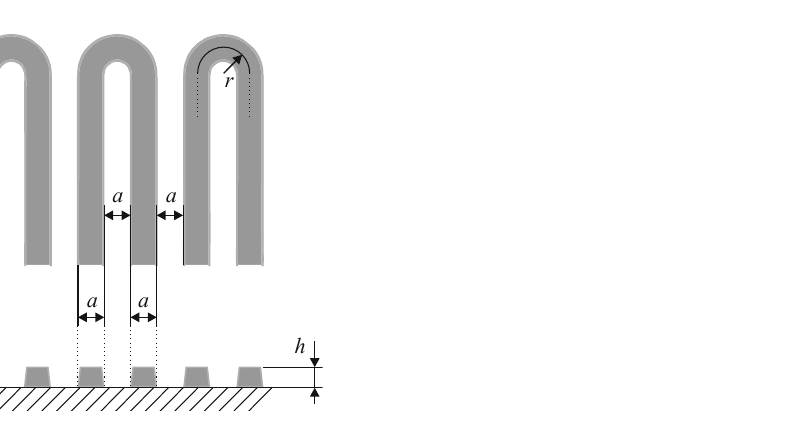
Figure 5. An example of the arced paths of the copper heating element of the thermostat, with the arc radius ( r ) indicated.